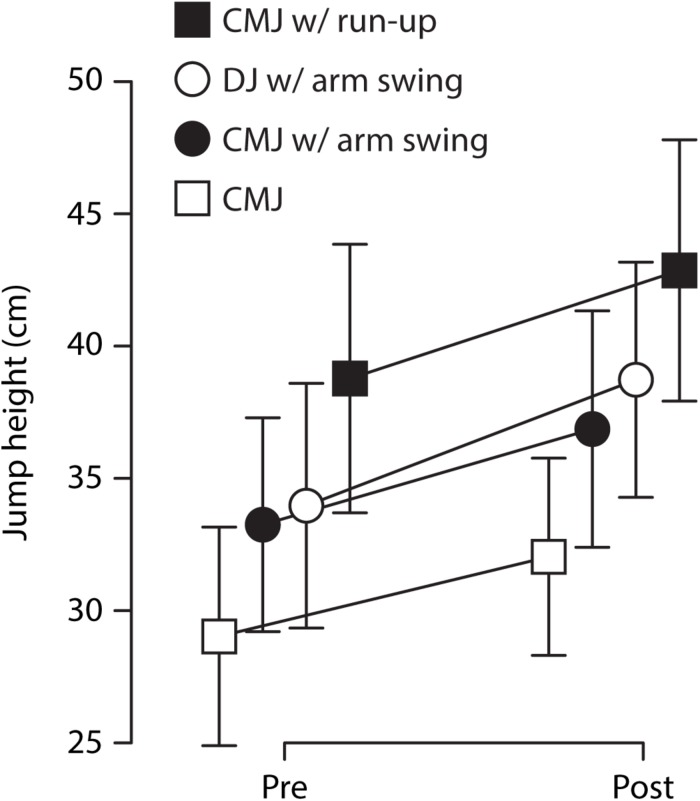
Mean jump heights (over both groups) in the four jump types before (Pre) and after (Post) training. Statistical analysis showed that jump height (p < 0.001) and improvements (p = 0.002) differed between jump types, with the greatest jump heights in the countermovement jump (CMJ) with run-up and the greatest improvements in the drop jump (DJ). Circles represent the jump types that were practiced. Error bars represent the standard deviation.